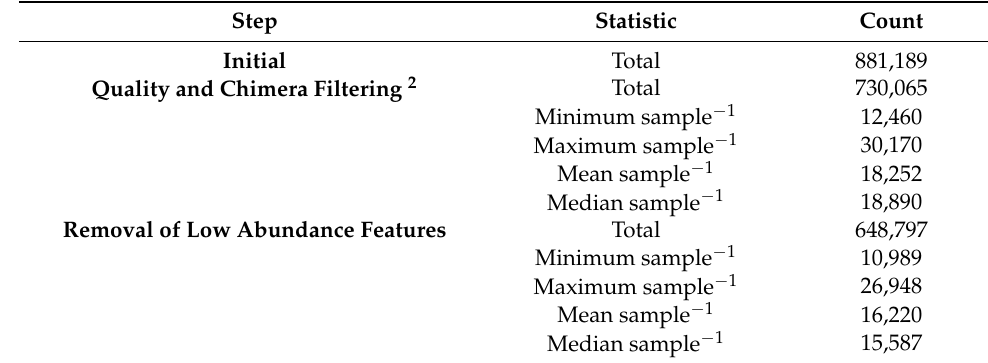
Table 2. 16S rRNA gene sequence read counts before and after filtering 1